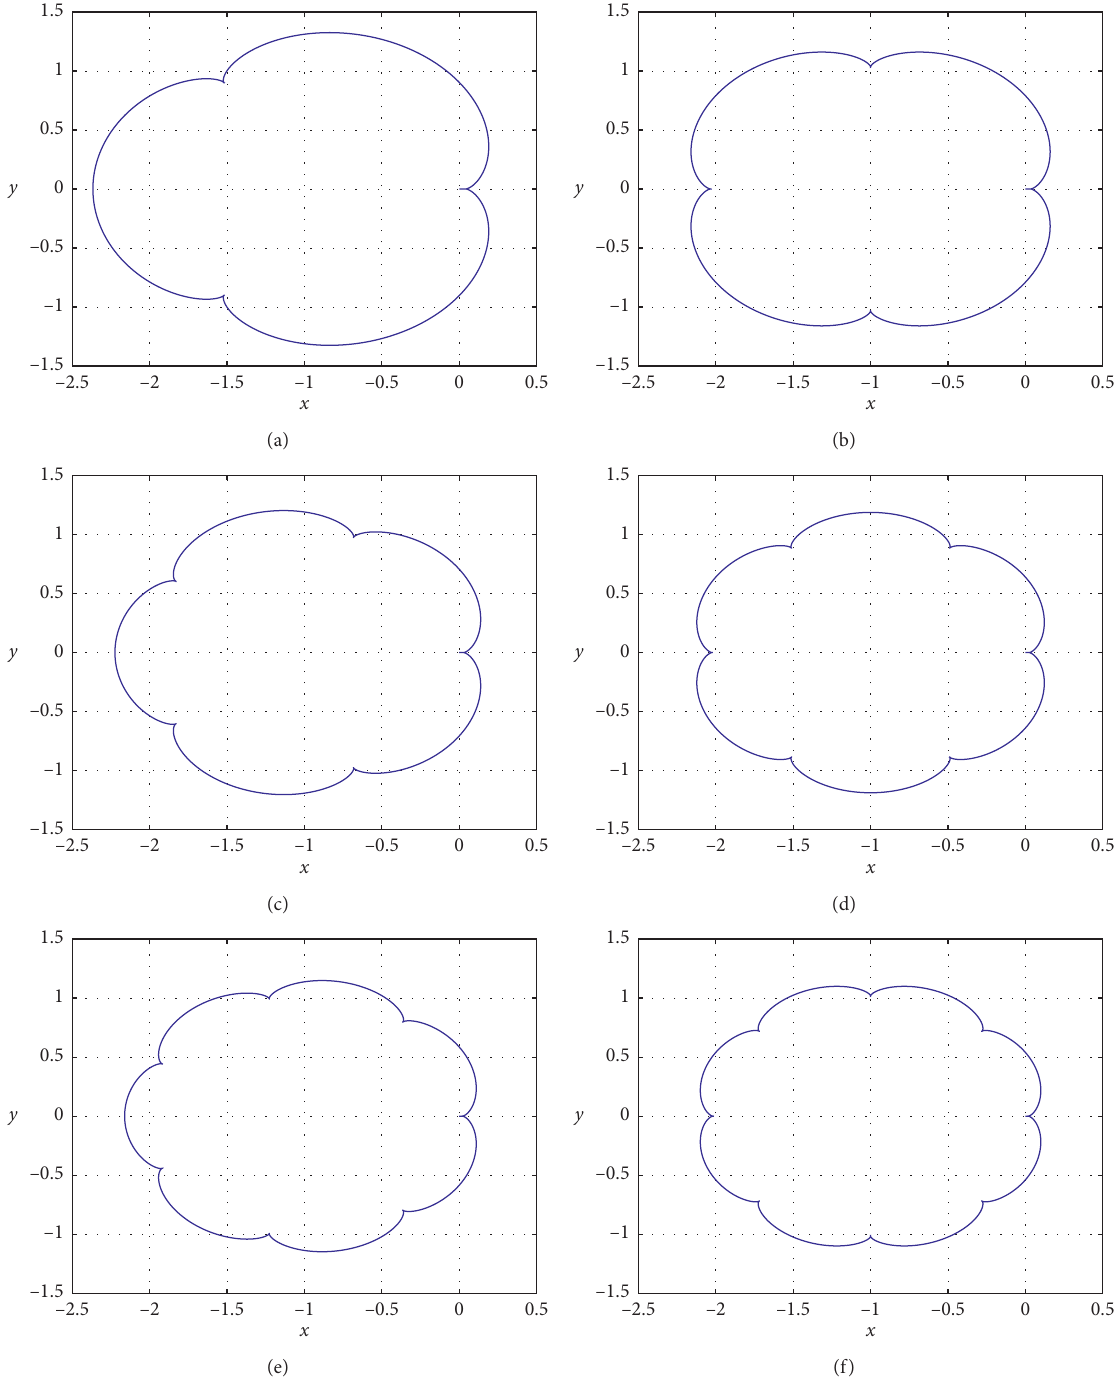
Figure 8: Periodic orbits when e � 0 . 2 ,f 0 � π /3 and velocity _ y 0 � 0 . 002. (a) Three loops orbit, when x 0 � 0.0396983975. (b) Four loops orbit, when x 0 � 0.031383115. (c) Five loops orbit, when x 0 � 0.0258816925. (d) Six loops orbit, when x 0 � 0.02197541025. (e) Seven loops orbit, when x 0 � 0.019059245000. (f) Eight loops orbit, when x 0 �